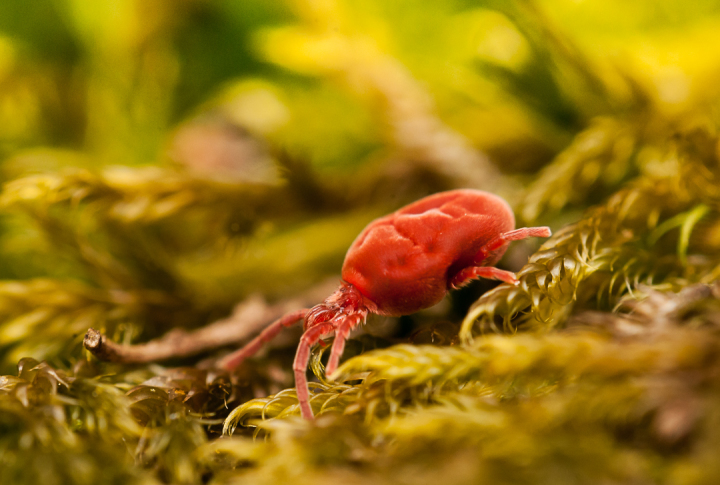
Allothrombium sp. Photo Anders Lindström.